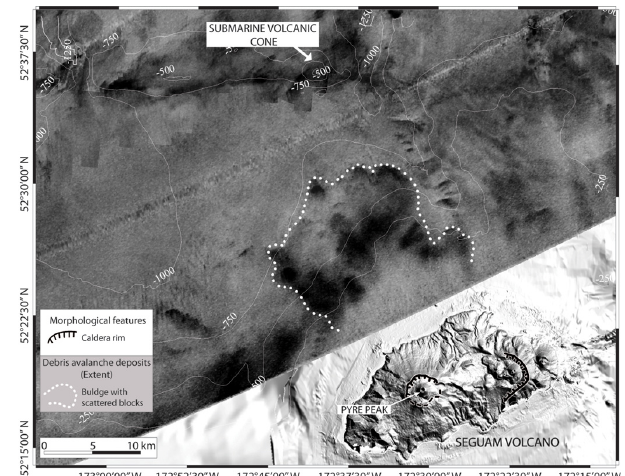
Fig. 11. Topography, bathymetry and Gloria side-scan data of Seguam Island and its northwest submarine part. On the north side a large submarine cone is also visible. For side scan data the black is high backscatter and white is low backscatter. Contour interval is